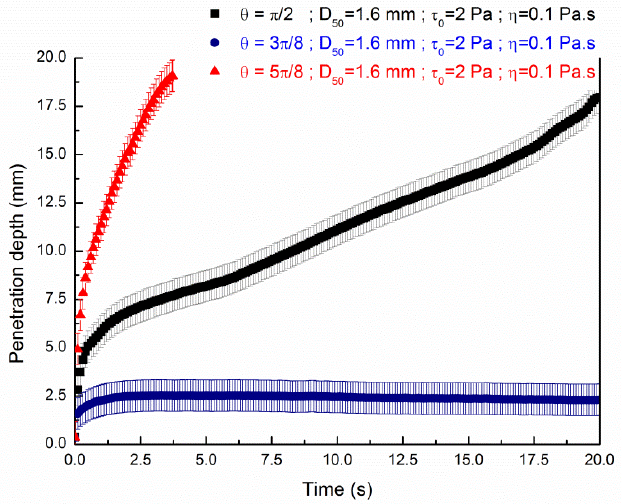
Figure 7. Influence of the contact angle at the interface for the penetration of a yield stress fluid (𝜏 0,𝑒𝑥𝑝 = 2 Pa; 𝜂 𝑒𝑥𝑝 = 0.1 Pa · s) in a sand bed particles of 20 mm height and d agg = 1.6 mm.